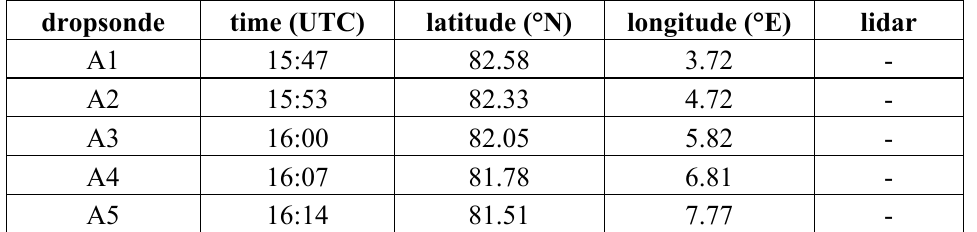
Table 1. Launch times and locations of the dropsonde measurements on 3 April 2009. The sondes used for case study A are highlighted in